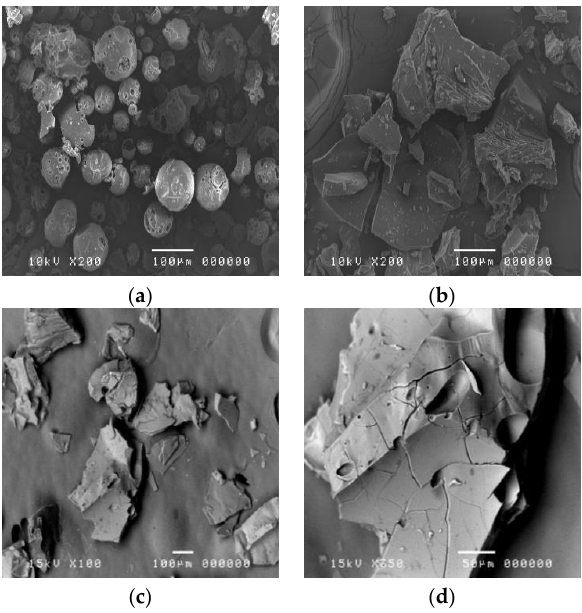
Figure 1. Scanning electron microscope (SEM) images of ( a ) HPβCD powder ; ( b ) blank HPβCD inclusion complex at magnification 200× and ( c ) CPSO- HPβCD inclusion complex at magnification 100× and ( d ) 350×.